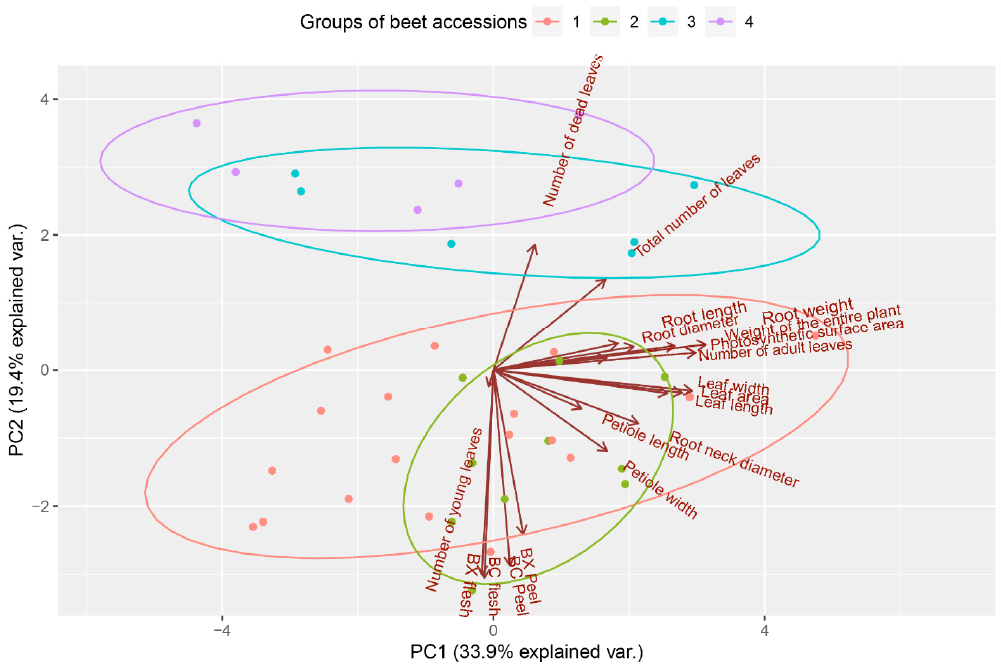
Figure 3. PCA plot showing beetroot color groupings. Metabolic processes in a plant are largely associated with anatomical and morpho- logical features, such as the structure of the leaf apparatus and the storage organ. The plant habitus depends on the combination of such leaf biomass characteristics, such as the shape and size of the leaf, number of leaves, and the thickness and length of the petiole. They build up the morphotype of the aboveground part of table beet plants and attest to their photosynthetic activity. The number of young and dead leaves on a plant is one of the markers used to form an idea of the table beet earliness level [39,46]. A correlation analysis among the groups of red-, yellow-, and white-colored table beet biotypes was performed to disclose the nuances of phenotypic differences in betalain-synthesizing ac- cessions. Morphological parameters were measured once a week, from 12 July to 14 Sep- tember, on 10 roots of each cultivar ( n = 100). The measurements showed that during the growing season, the vector of correlations did not change: negative relationships varied only within the negative range, and positive within the positive one, confirming the gen- eral tendency. There were strong positive relationships between BC and BX in both the peel (r = 0.97, p < 0.001) and the flesh (r = 0.79, p < 0.05) among all red-colored accessions (Figure 4). The yellow-colored biotypes also showed strong positive correlations between betalains in the peel (r = 0.97, p < 0.001) and notable ones in the flesh (r = 0.53, p < 0.05) (Figure 5). In the year of testing, a noticeable positive correlation of betalains appeared with the weight of the root, its parameters and the number of leaves on the plant, which had not previously been observed by us or other authors [24,26,38,47]. It had earlier been shown that beetroots with a diameter of 4.6–6.4 cm contained more betalains than larger ones, with a diameter of 9 cm. Our results were an exception to the rule that did not change the known pattern and were associated with an abnormally hot and dry summer in 2022. Despite the absence of a direct negative correlation between betalains and yield parameters, its indirect signs were found. The difference in the red-colored biotypes was a strong negative dependence of BC and BX on the width of the leaf blade (r = − 0.85–0.88, p < 0.01) and a significant